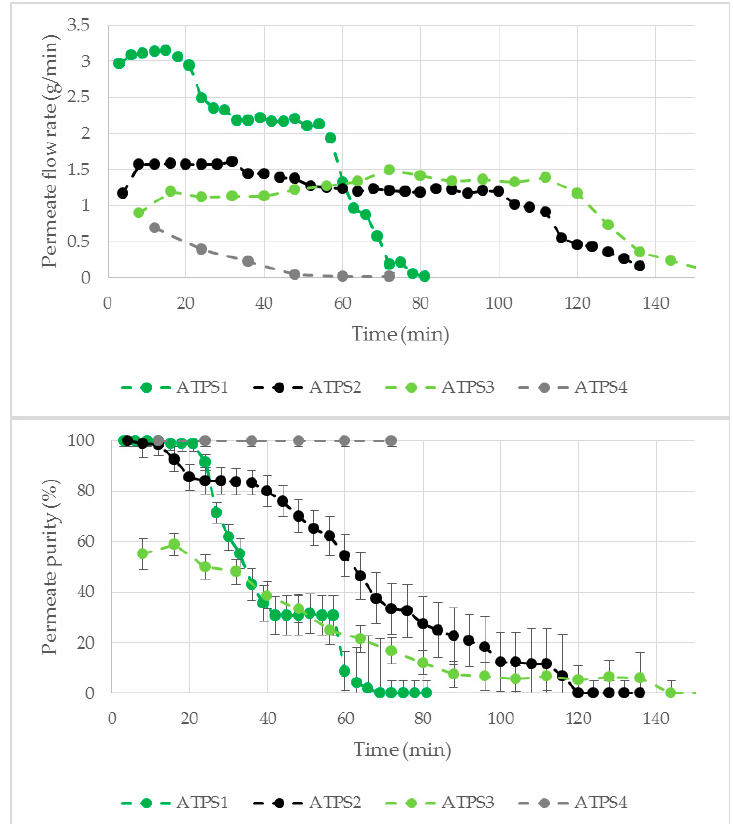
Figure 8. Flow rate ( above ) and purity ( below ) of the permeate by membrane based phase separation for ATPS1–4. Water was used as feed component. V = 150 mL, TMP = 10 mbar, ∆ P = 30 mbar, Q = 16.7 mL/min.